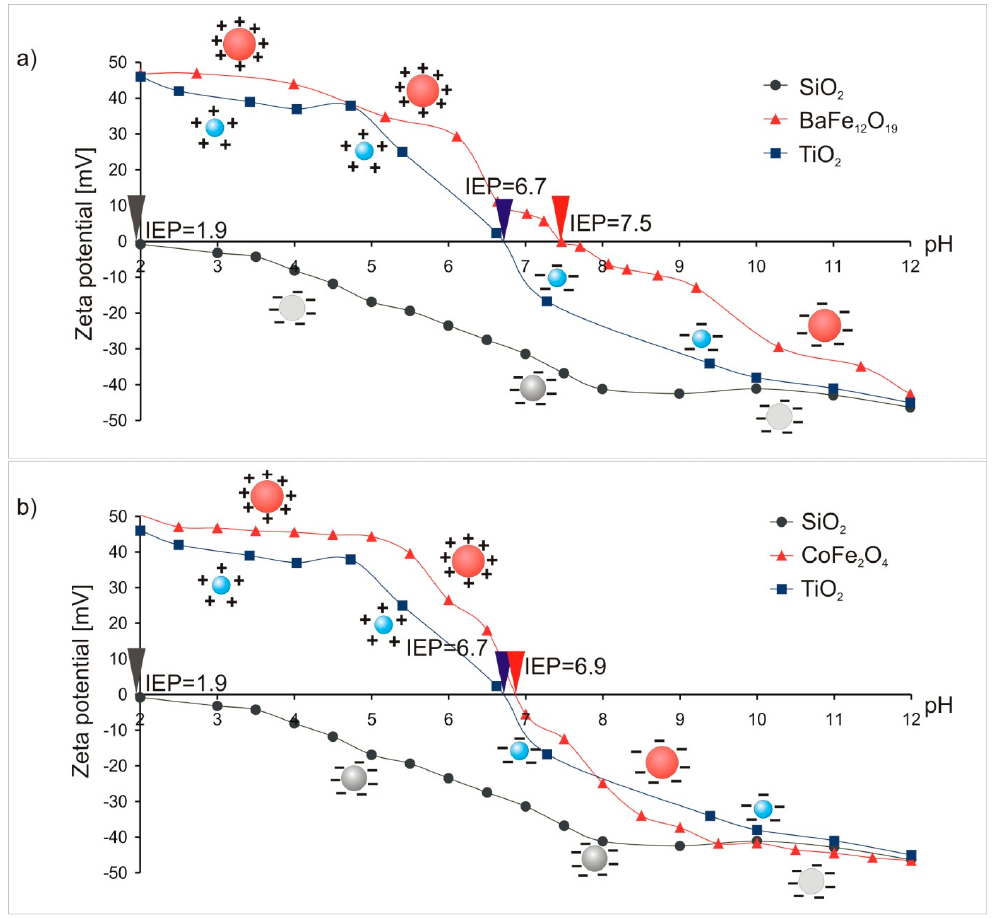
Figure 3. Zeta potential of CoFe 2 O 4 ( a ) and BaFe 12 O 19 ( b ) determined from the electrophoretic mobility in dependence of the pH, I = 1 × 10 − 4 M KCl.